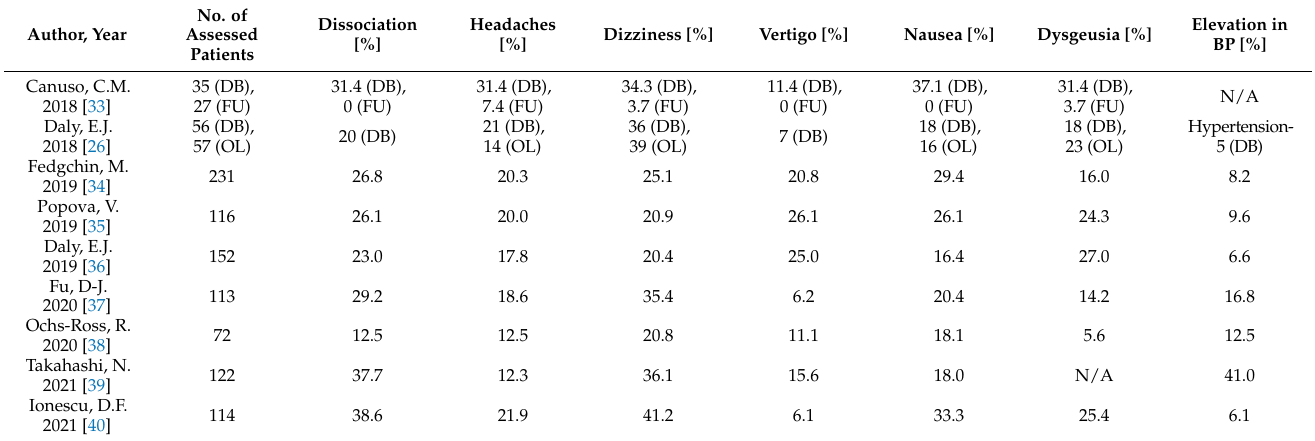
Table 6. The most common adverse effects during esketamine treatment.